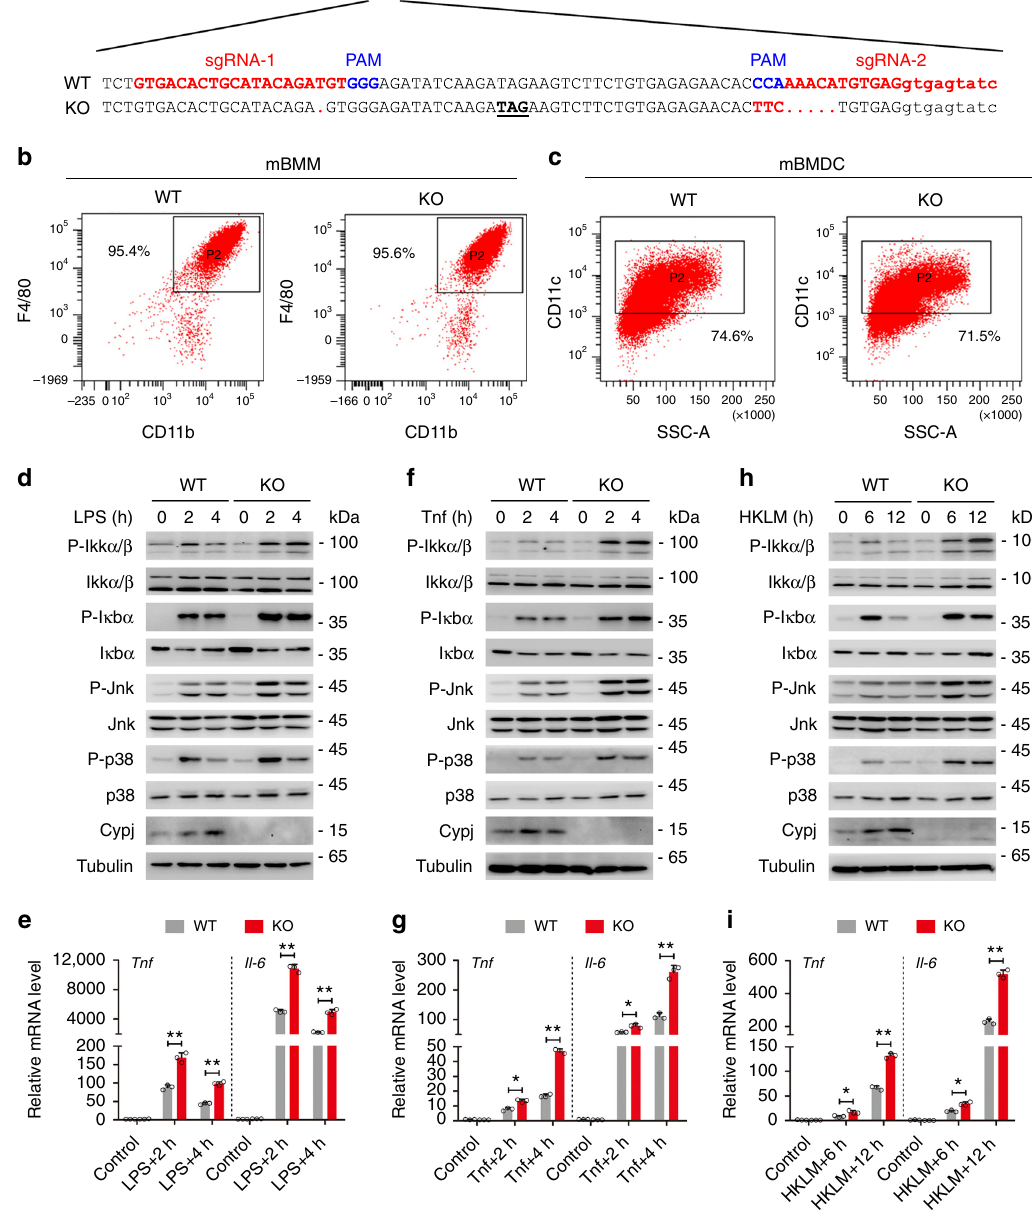
Fig. 2 Cypj de fi ciency activates the NF- κ B signaling in primary mBMM cells. a The strategy of CRISPR-Cas9 mediated genomic edition. A gene speci fi c guide RNA (sgRNA) was used to achieve the targeting. b , c Percentage of mBMMs ( b ) and mBMDC ( c ) were analyzed by their speci fi c lineage markers between WT and KO mice. d – i WT and Cypj-de fi cient primary mouse BMM cells were treated with or without LPS (100 ng ml − 1 ) ( d , e ), Tnf (20 ng ml − 1 ) ( f , g ), or HKLM (10 7 CFU ml − 1 ) ( h , i ) for different times; Cypj abundance and the phosphorylation of the indicated proteins ( d , f , h ), as well as transcription of Tnf and Il-6 ( e , g , i ; N = 3) were detected. Error bars indicate S.D.; * p < 0.05, ** p < 0.01 (two-tailed Student ’ s t